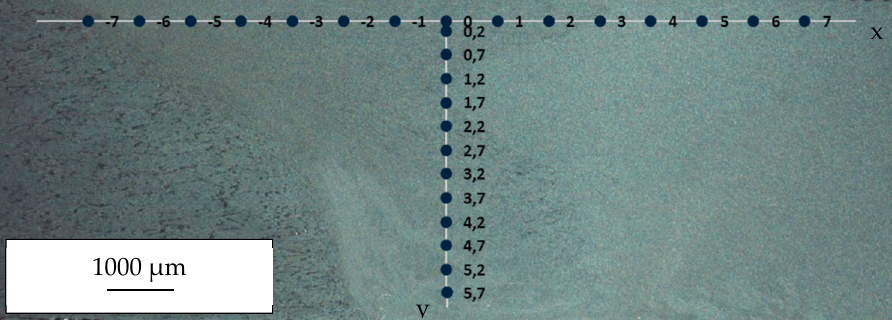
Figure 12. Hardness measurement positions.